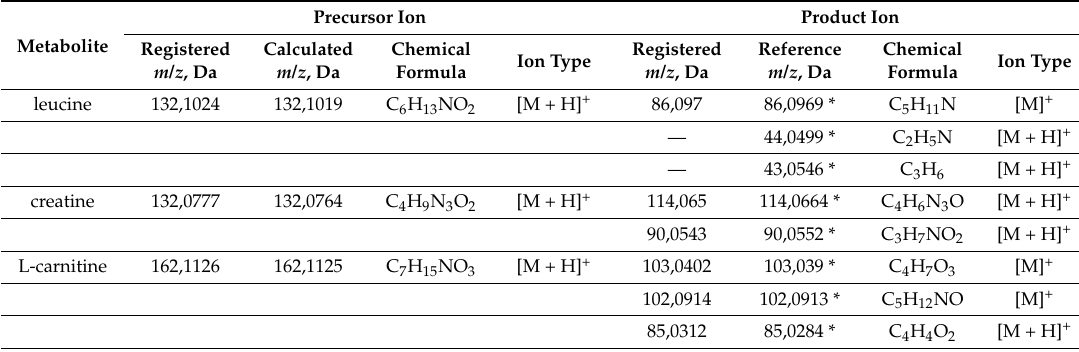
Table 2. Identification of selected metabolites by MS/MS fragmentation.